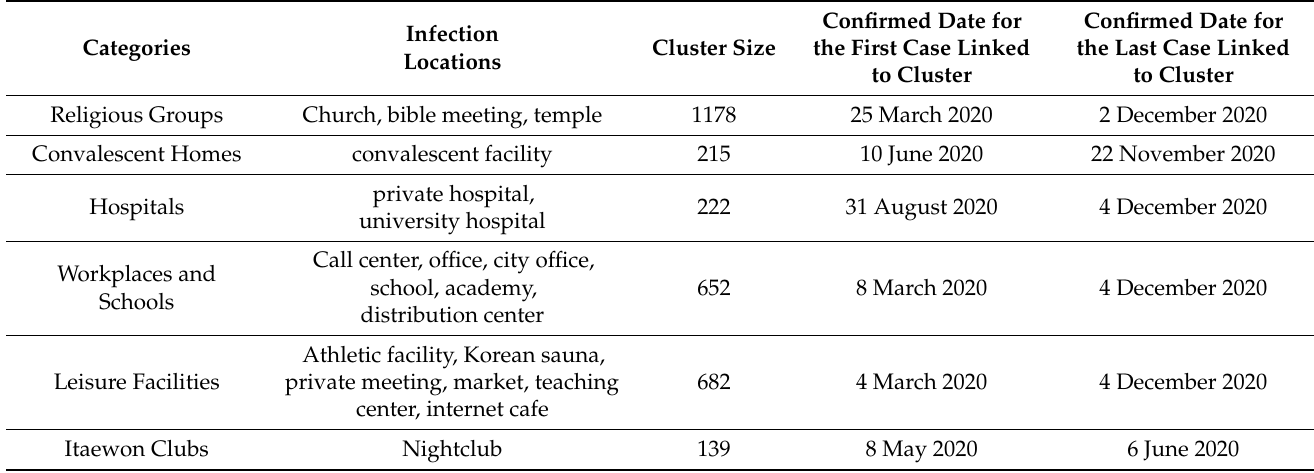
Figure 1. The epidemic curve of weekly confirmed cases of COVID-19 in Seoul, South Korea over the confirmed dates. The pie graph shows the ratio of clusters by category. The red curve represents the cumulative number of confirmed cases corresponding to the left vertical axis. Table 1. Characteristics of COVID-19 cluster categories in Seoul, South Korea as of December 4, 2020 excluding “Others” category.